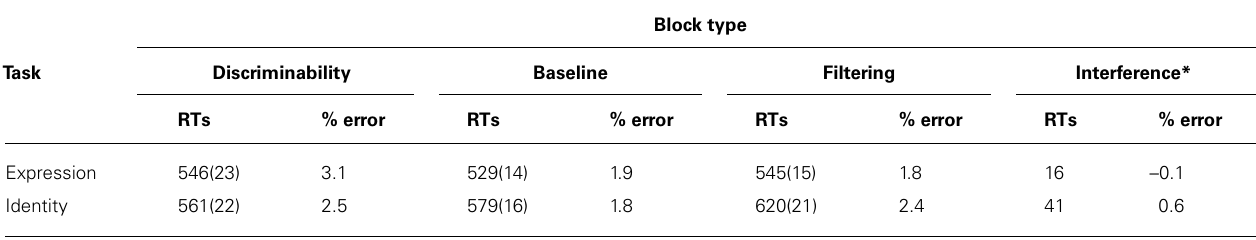
Table 3 | Mean reaction times (in milliseconds), standard errors (in parentheses), and percentages of error of performance in both identity- and expression-judgment tasks during discriminability assessment and interference measurements of Experiment